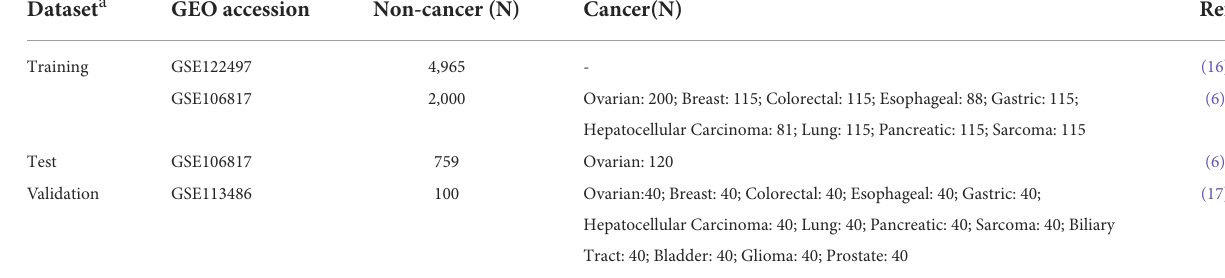
TABLE 1 The datasets and samples analyzed in the